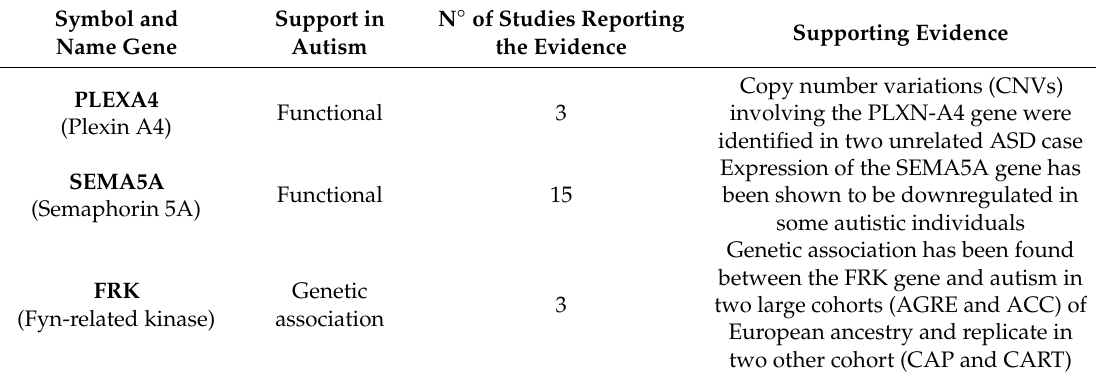
Table 1. PlexinA4 (PLEXA4), semaphorin 5A (SEMA5A) and Fyn-related kinase (FRK) gene association analysis in ASD patients. Adapted from Schafer et al. (2019)